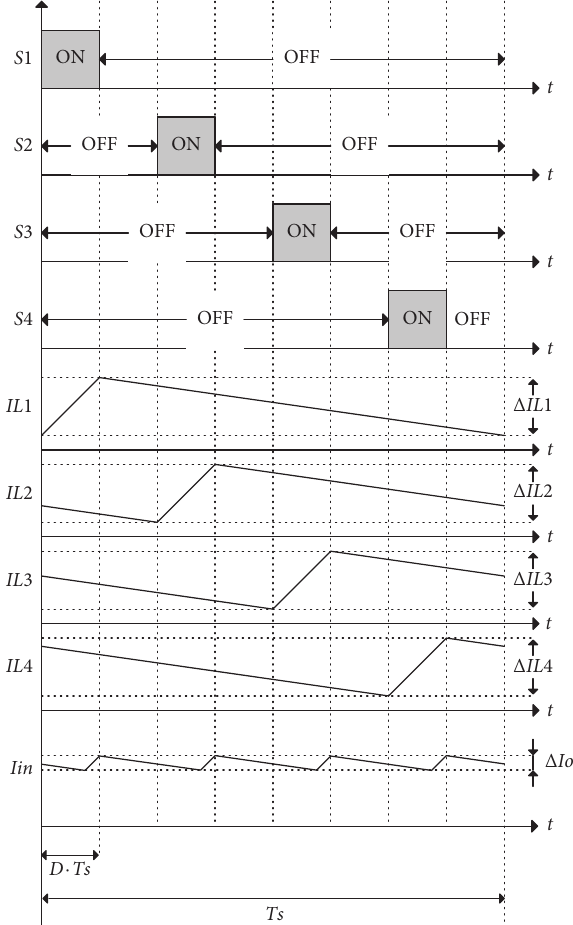
Figure 3: Switching pattern and inductor current waveform in range of the duty ratio less than